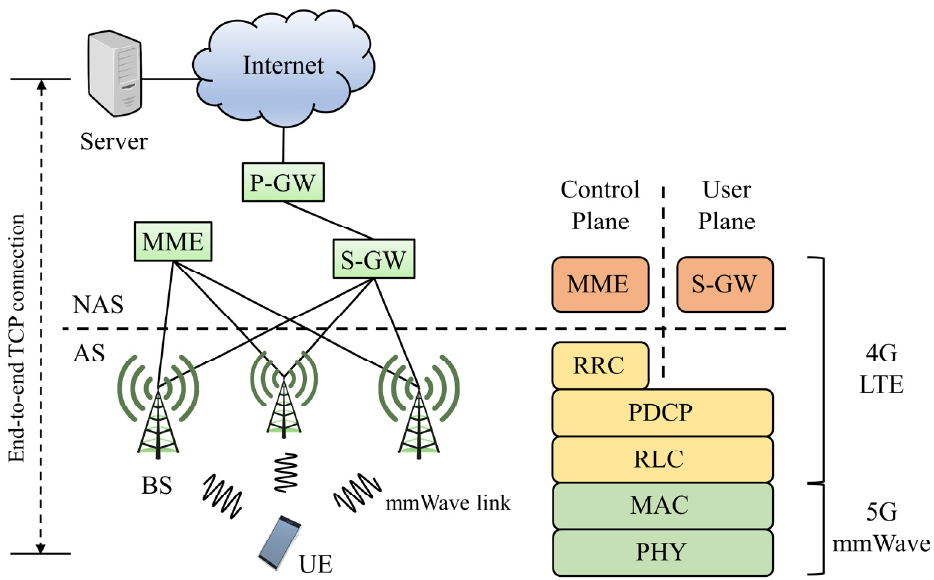
Figure 1. End-to-end TCP connection over 5G mmWave link.